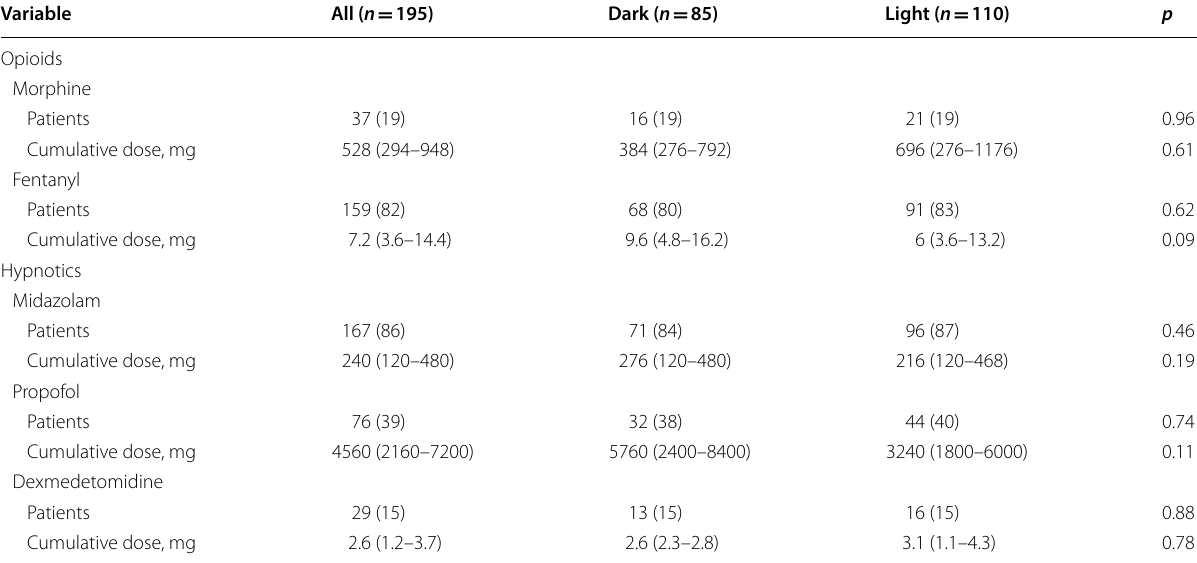
Data are median (interquartile range) or numbers (percentage)